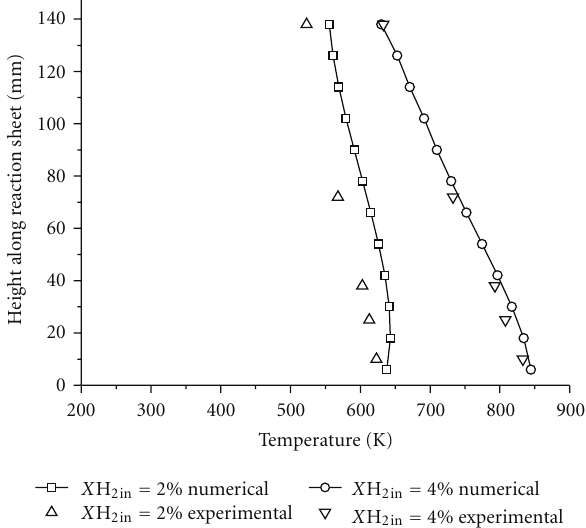
Figure 4: Catalyst surface temperature along the catalytic sheet (central plate) for REKO facility, comparison of CFD results with experimental results for inlet hydrogen mole fraction 2% & 4% and temperature